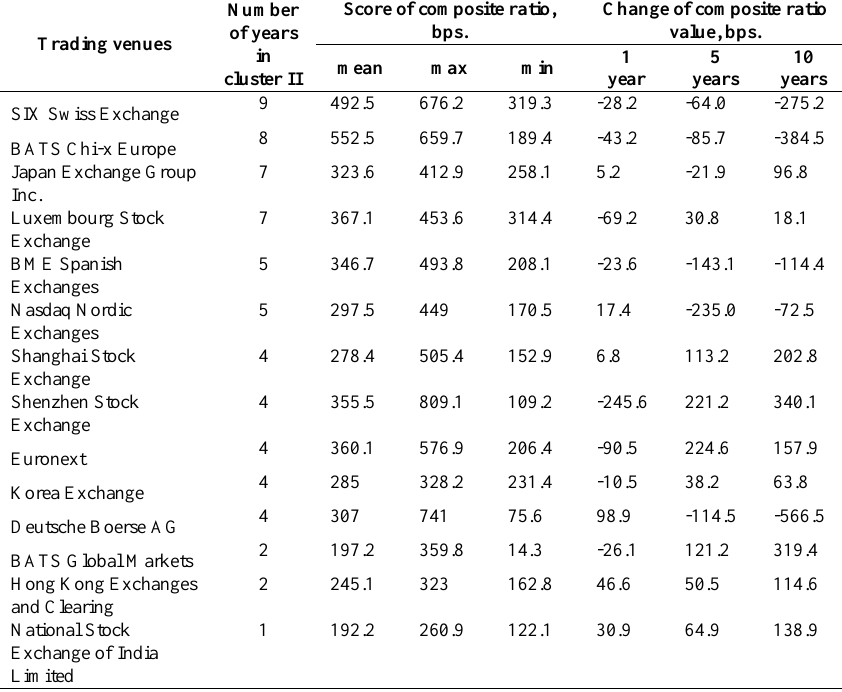
Table 4. Group II statistics by composite ratio (2008–2017) Number of years Trading venues